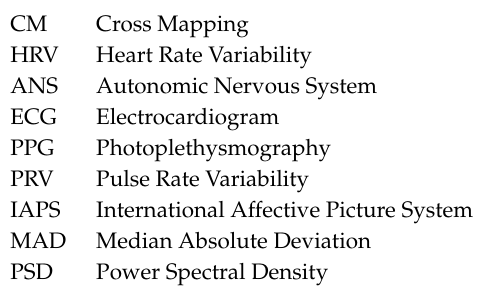
s1, Figure S1: Boxplots related to kurt f (blue) and kurt w (green) values in the whole experimental protocol. Figure S2: Boxplots related to shannon f (blue) and shannon w (green) values in the whole experimental protocol. Figure S3: Boxplots related to ρ f (blue) and ρ w (green) values in the whole experimental